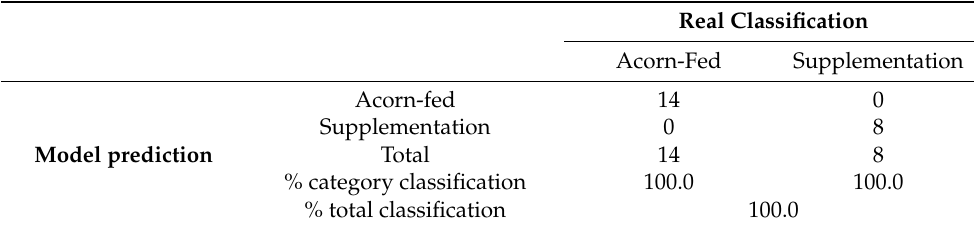
Table 2. External validation results (confusion matrix) obtained by the PLS-DA model (Model 2) using blind samples for the targeted approach (individual features).